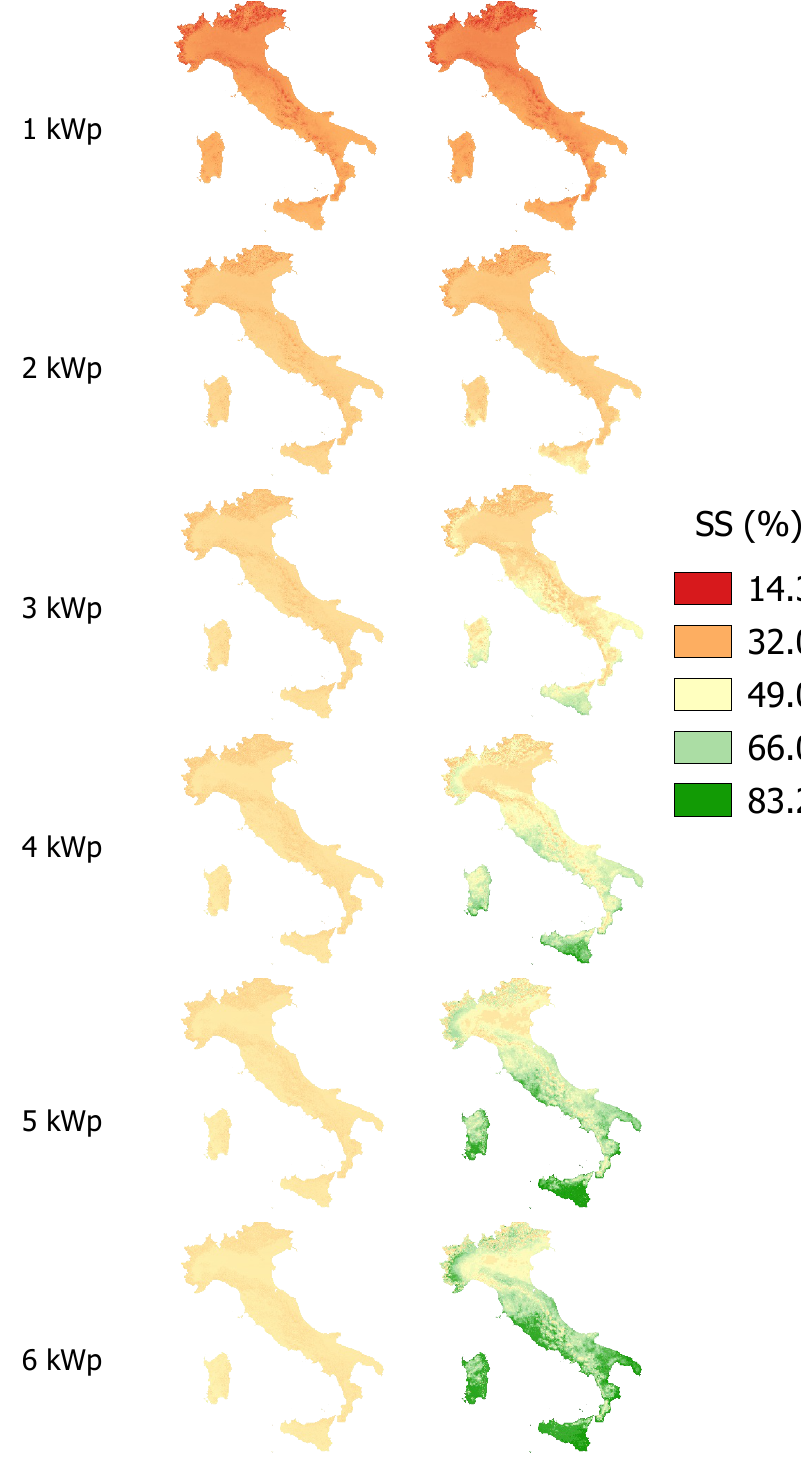
Figure A16. SS for E L = 4000 kWh, left side without battery and right side with